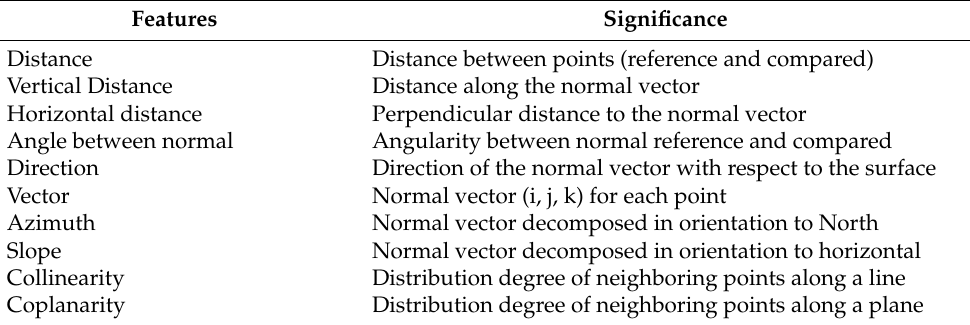
Table 1. Summary of the new features computed with the adaptation of the M3C2 [18] algorithm im- plemented in PCM software. Comparison between the distances of the 3D point clouds is performed in the direction defined by the reference normal vectors. Results are associated with a new point cloud with these